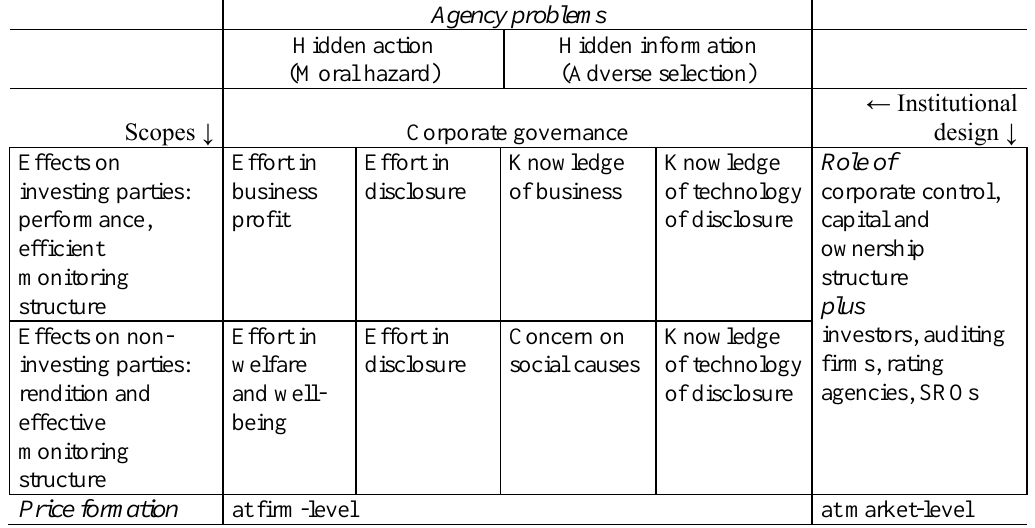
Table 2.1: A Synopsis of Agency Problems and Their Effects in Price